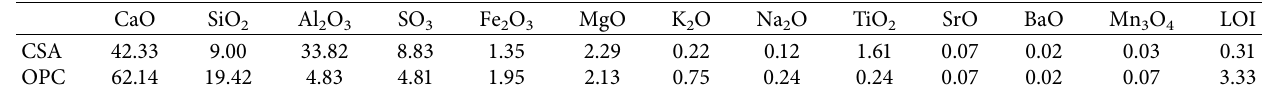
Table 2: Oxide composition of the CSA and OPC cement powder (by wt.